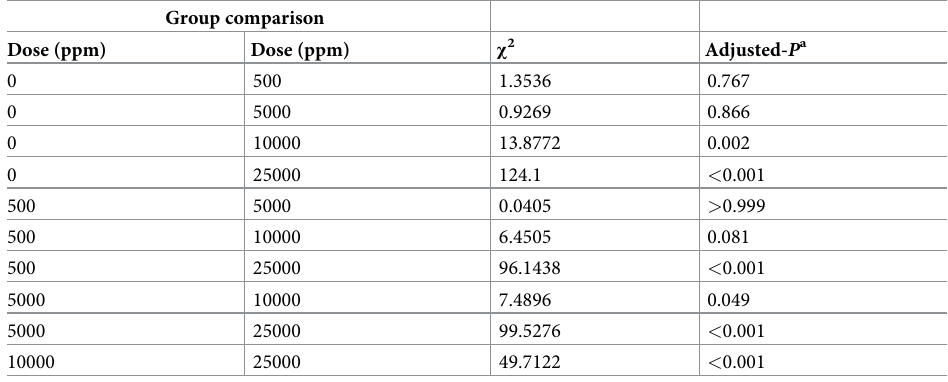
Table 1. Multiple comparisons among survival functions of Lygus hesperus adults fed diet containing doses of Tagetes patula (Marigold) aqueous extract. Group